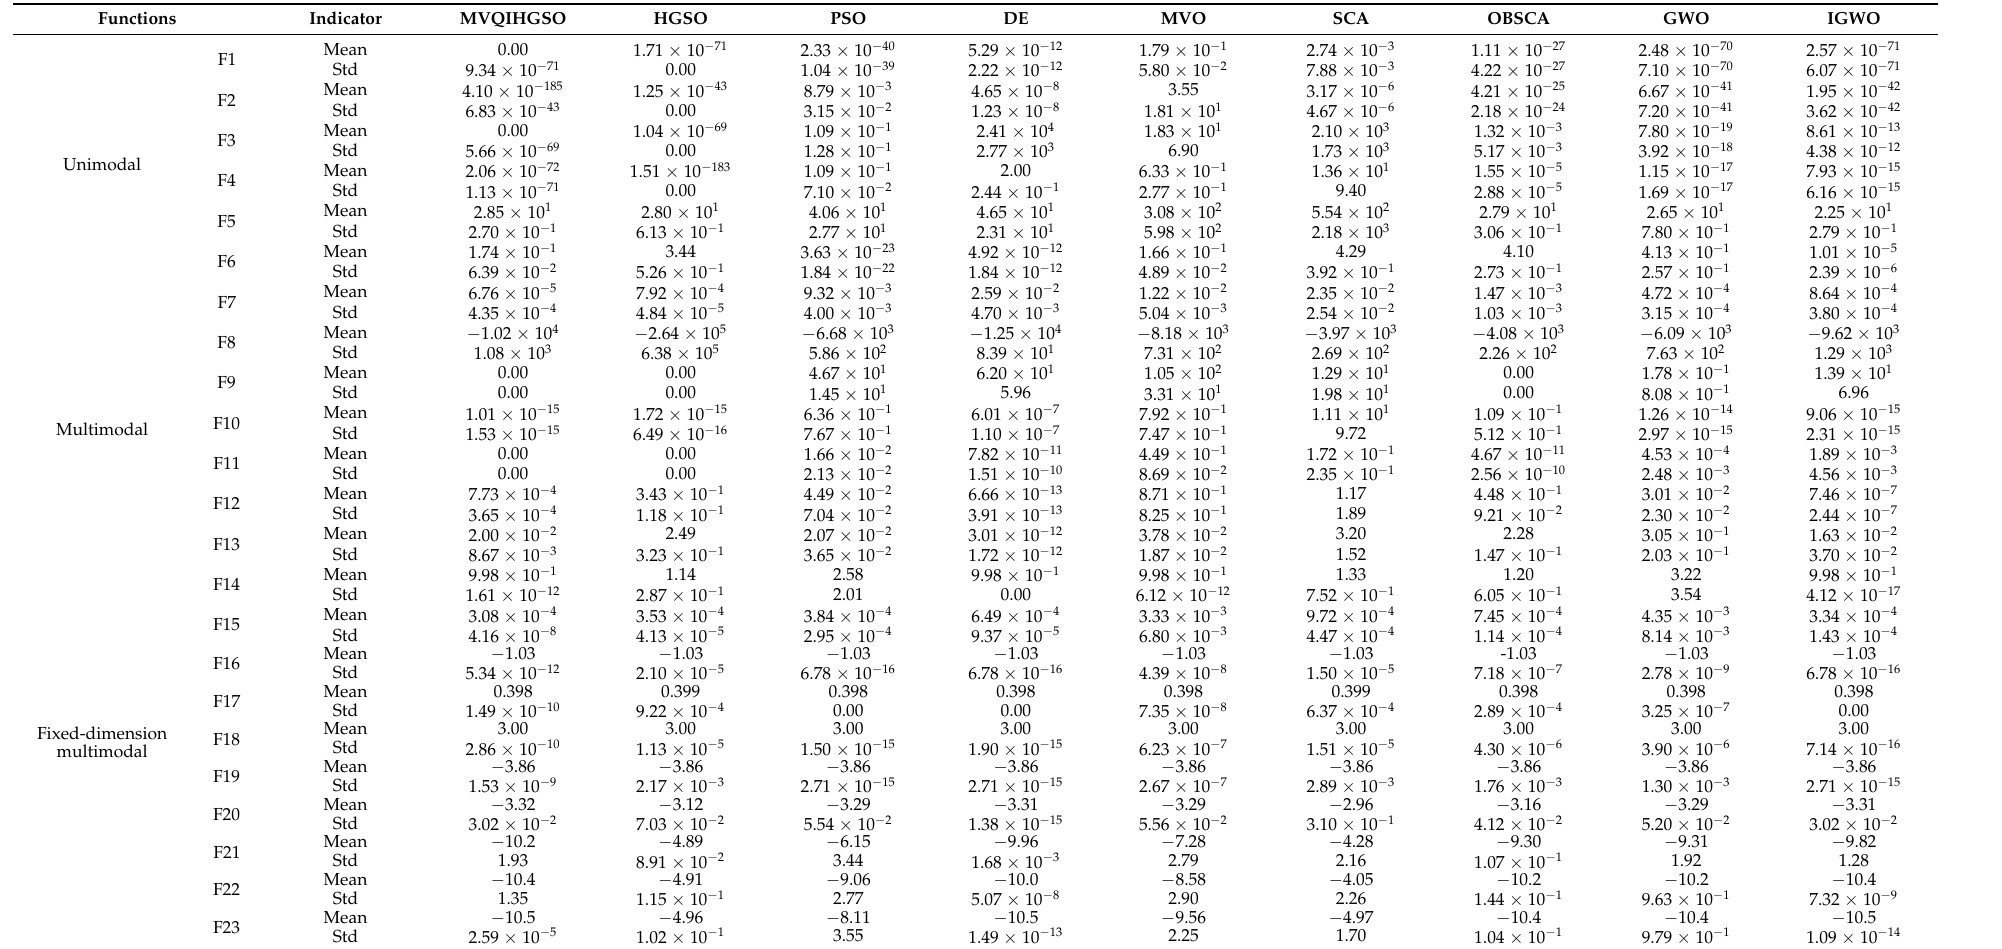
Table 4. Statistical results of the proposed MVQIHGSO and other state-of-art